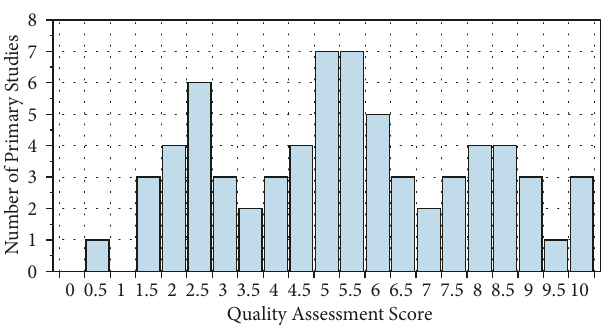
Figure 2: Quality-wise distribution of